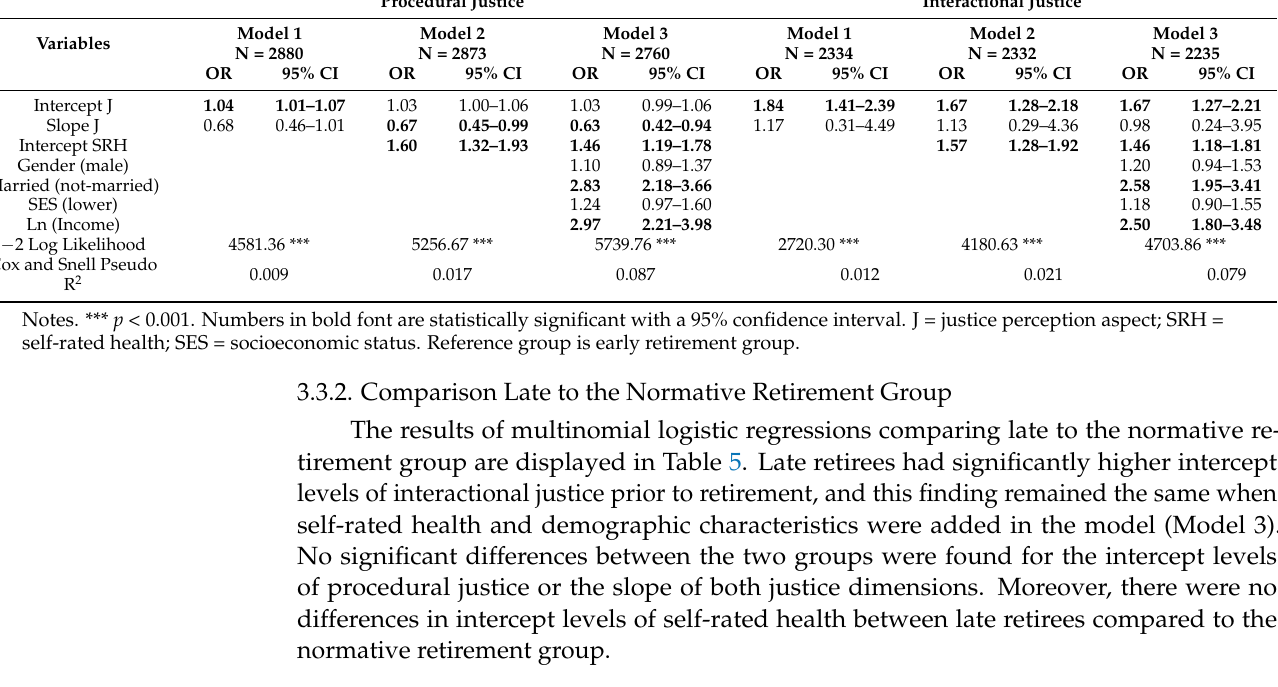
Table 5. ORs for late retirement as compared to normative retirement (reference group) for procedural justice and interac- tional